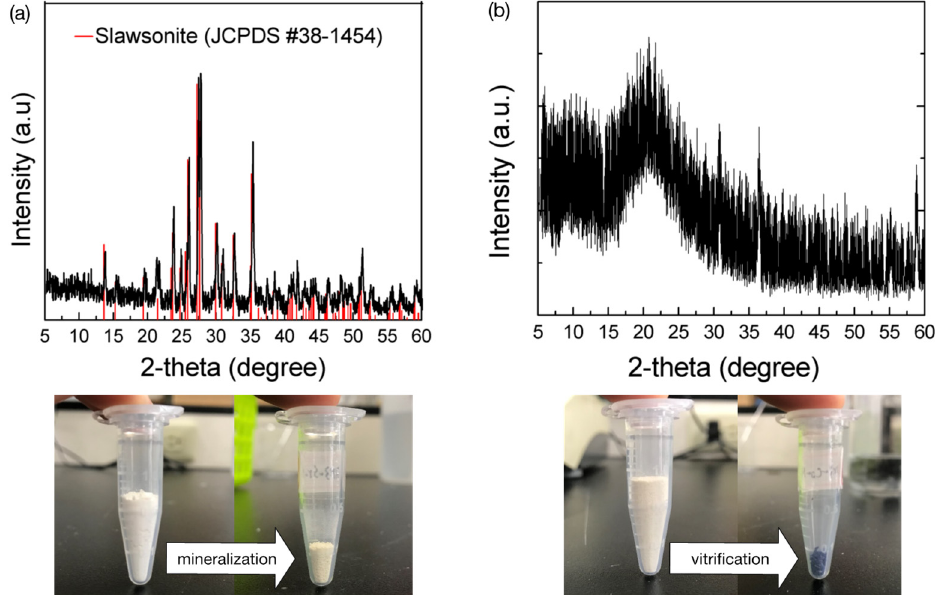
Figure 9. XRD patterns of BK3 containing the adsorbed ( a ) Sr 2+ and ( b ) Co 2+ calcined at 1300 °C for 2 h.